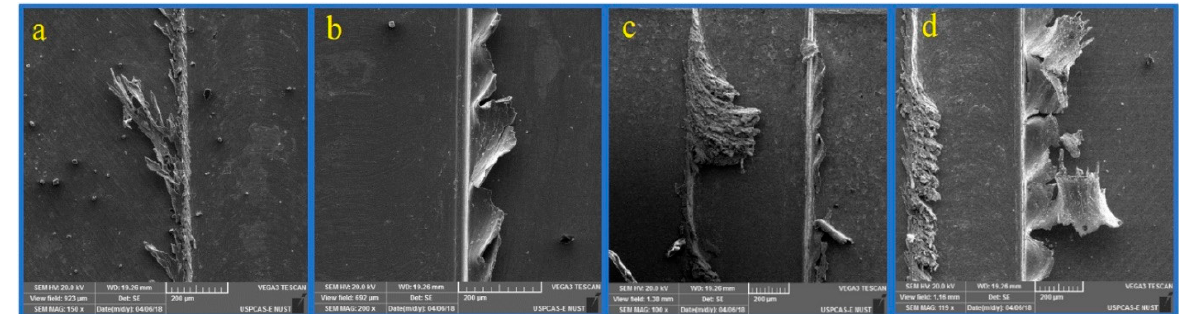
Figure 8. Burr types observed in the study: ( a ) Feathery burr ( a P = 10 µm, V C = 8 m/min, f Z = 1 µm/tooth, nACo); ( b ) rollover burr ( a P = 30µm, V C = 10 m/min, f Z = 0.6 µm/tooth, AlTiN); ( c ) Poisson burr ( a P = 90 µm, V C = 10 m/min, f Z = 0.2 µm/tooth, AlTiN); ( d ) rollover burr/Poisson burr ( a P = 60 µm, V C = 12 m/min, f Z = 0.2µm/tooth, TiSiN).